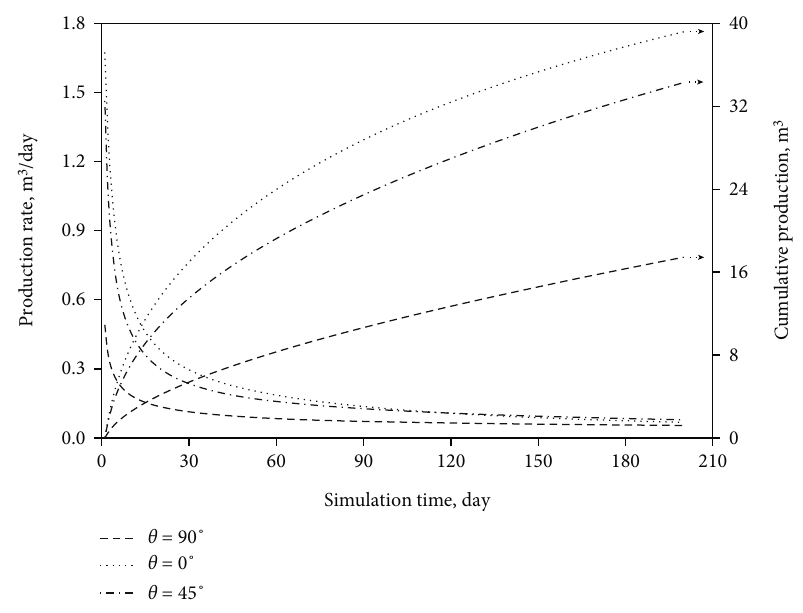
Figure 11: Comparison of well performances of the three models with di ff erent well placement